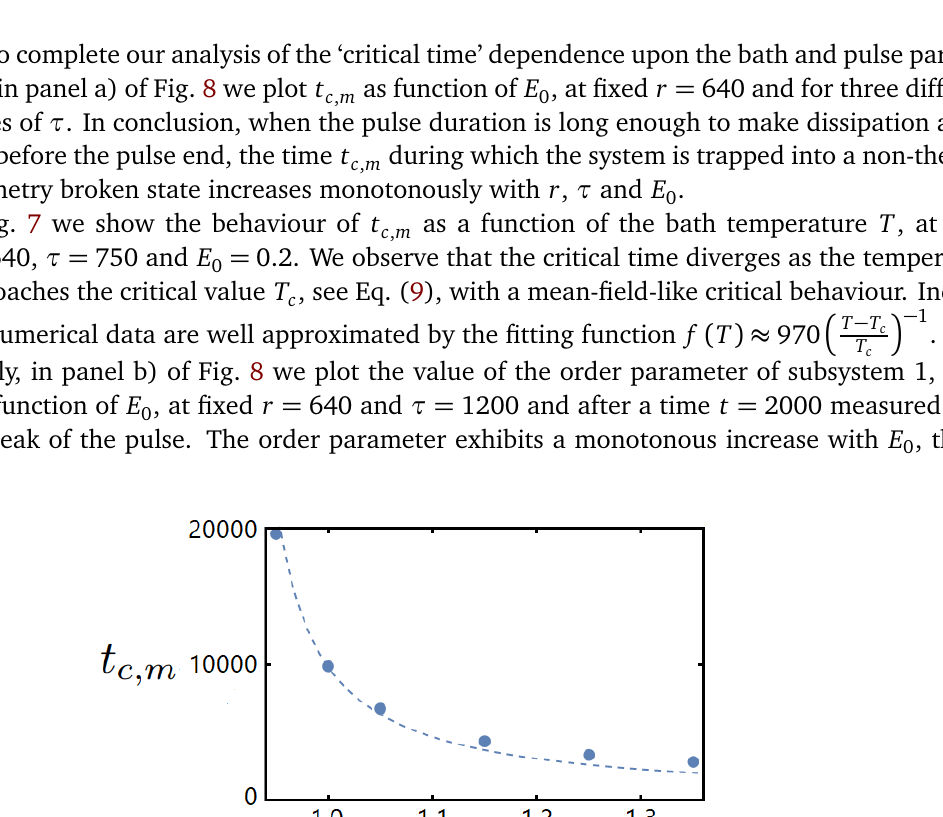
Figure 7: Critical time t and τ = 750. The dashed line is the fitting function f ( T ) ≈ 970 given by Eq.